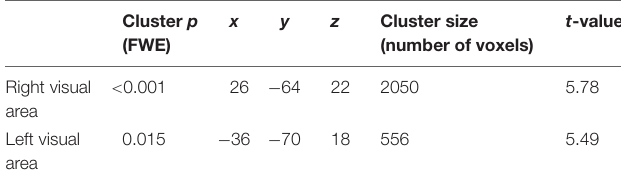
TABLE 1 | Significant activation for common aversive effects [aversive (rubber-hand + human-hand) > non-aversive (rubber-hand + human-